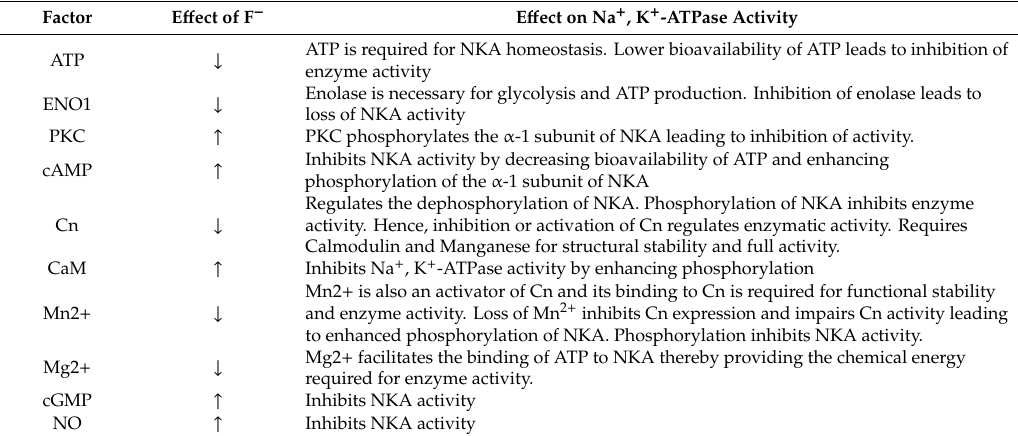
Figure 2. Schematic representation of the molecular mechanisms and biological pathways by which fluoride inhibits Na + , K + -ATPase activity on plasma membranes and in thyroid follicular cells. Table 2. Key molecular mechanisms by which fluoride inhibits Na + , K + -ATPase activity. Arrows refer to increases ( ↑ ) or decreases ( ↓ ) in regulation or expression by fluoride.